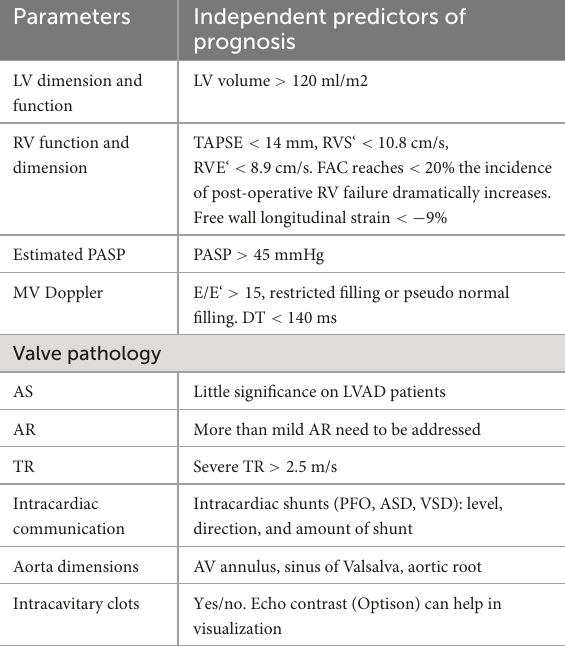
Parameters Independent predictors of prognosis LV dimension and